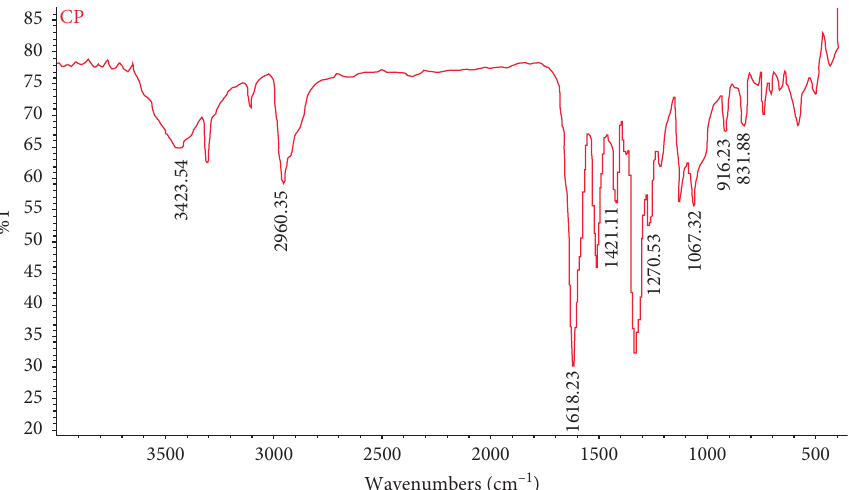
Figure 2: FT-IR analysis of CeO2 nanoparticles.